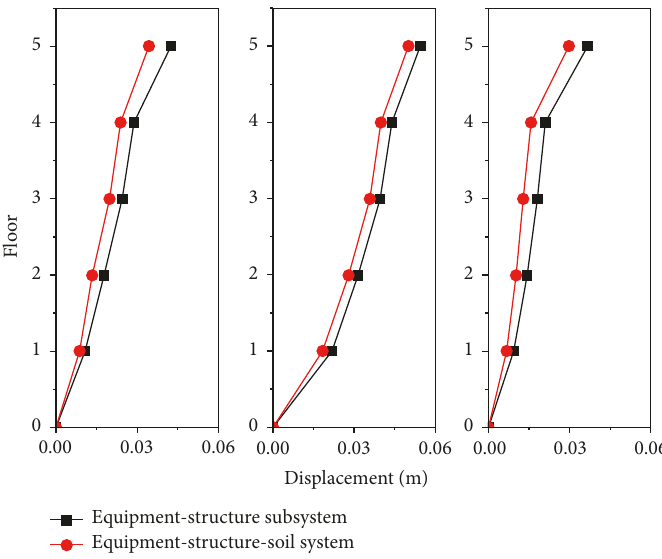
Figure 15: Peak displacement responses during the medium